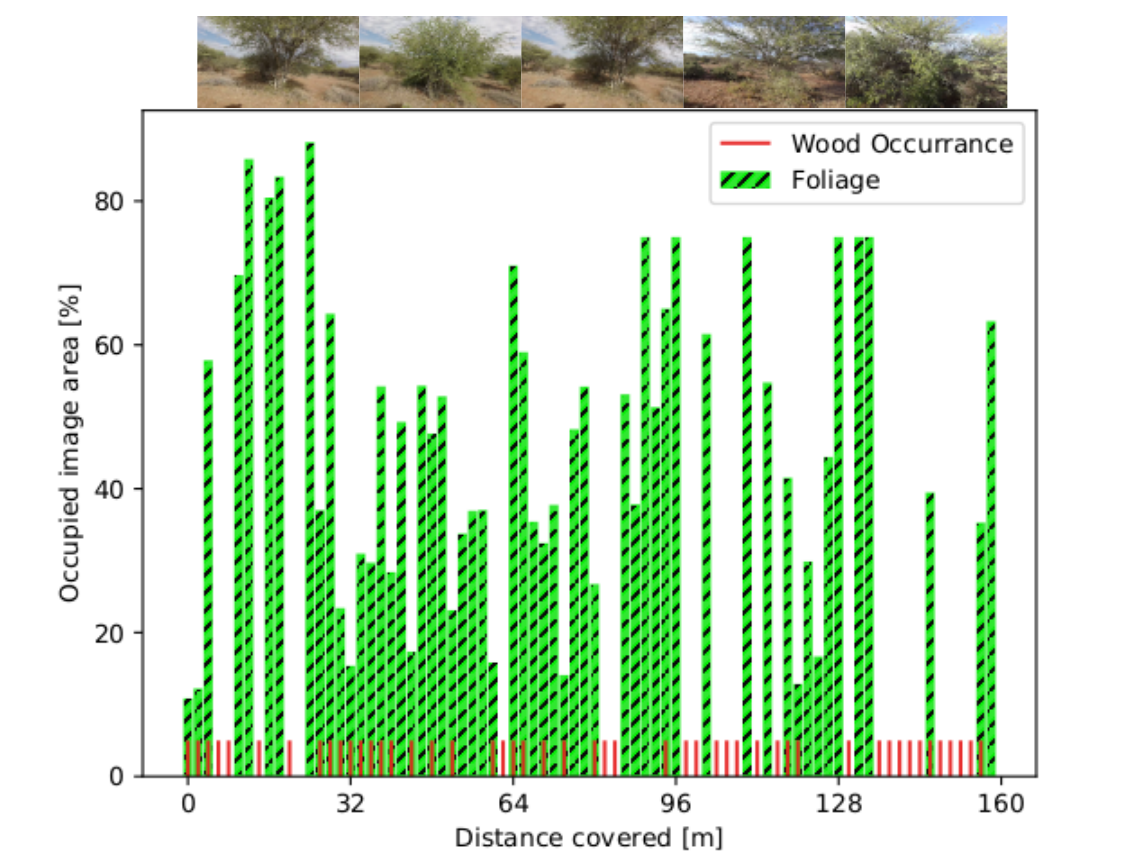
Figure 8. Bar chart output, where a video-stream was analyzed. Red carets show the probability of a tree occurrence, while green indicates a possible biomass yield. Above the image, sample pictures are displayed, which represent the images at distances of 1 m, 32 m, 64 m, 96 m, and 128 m, respectively.